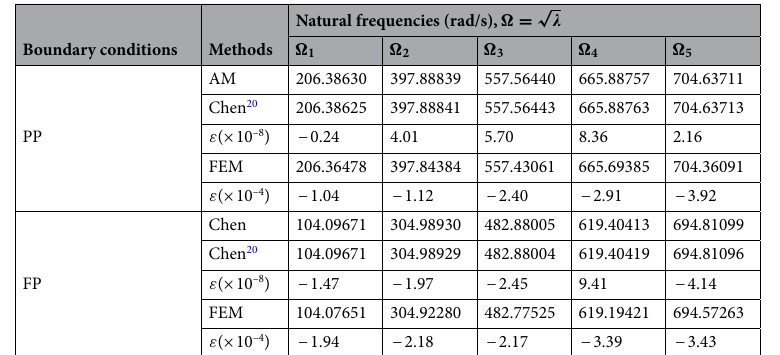
Natural frequencies (rad/s), (cid:31)